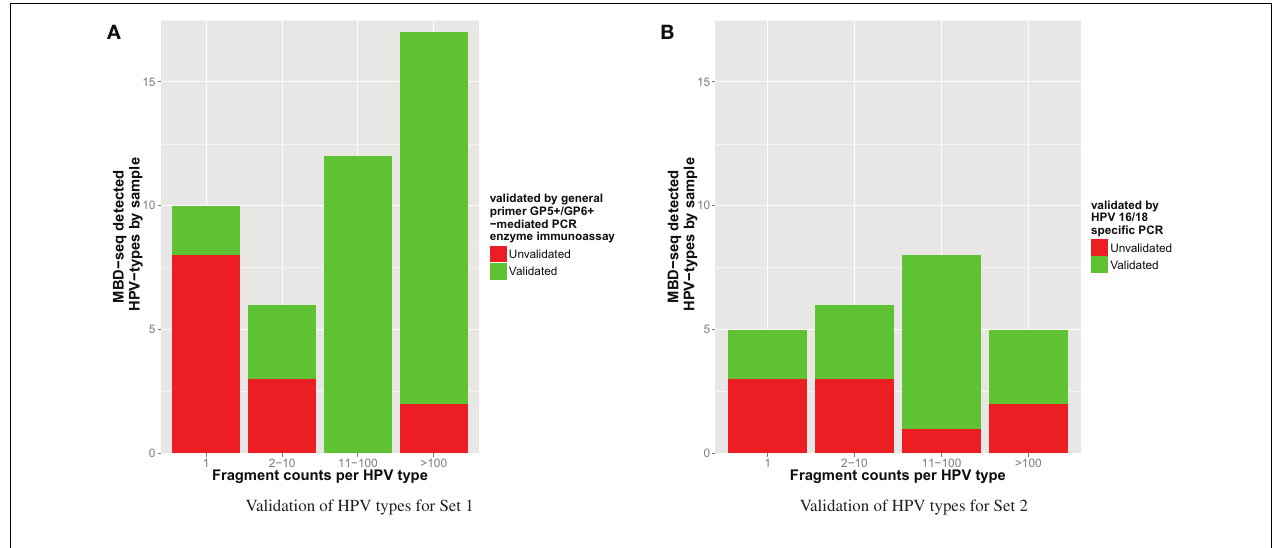
FIGURE 4 | HPV type